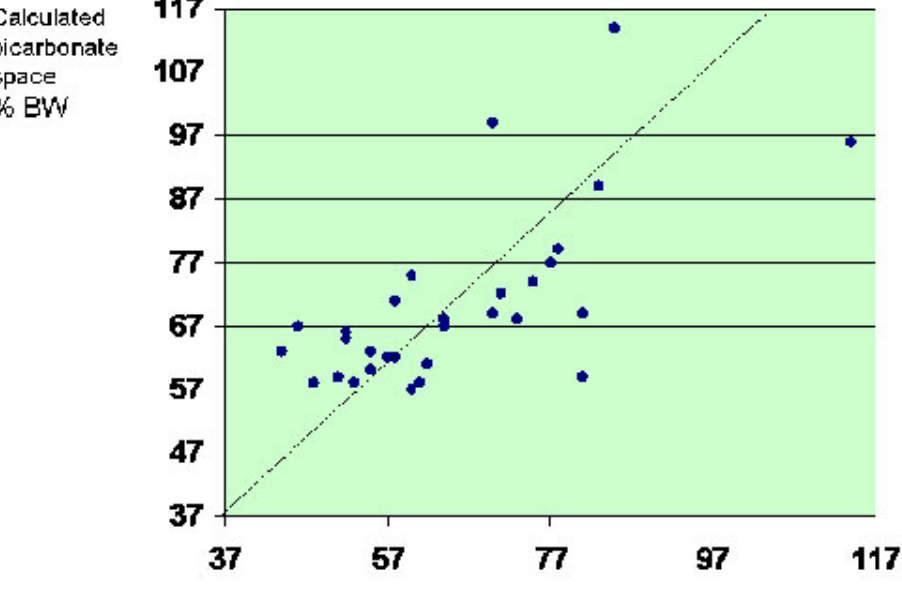
FIGURE 2. Measured bicarbonate space. %